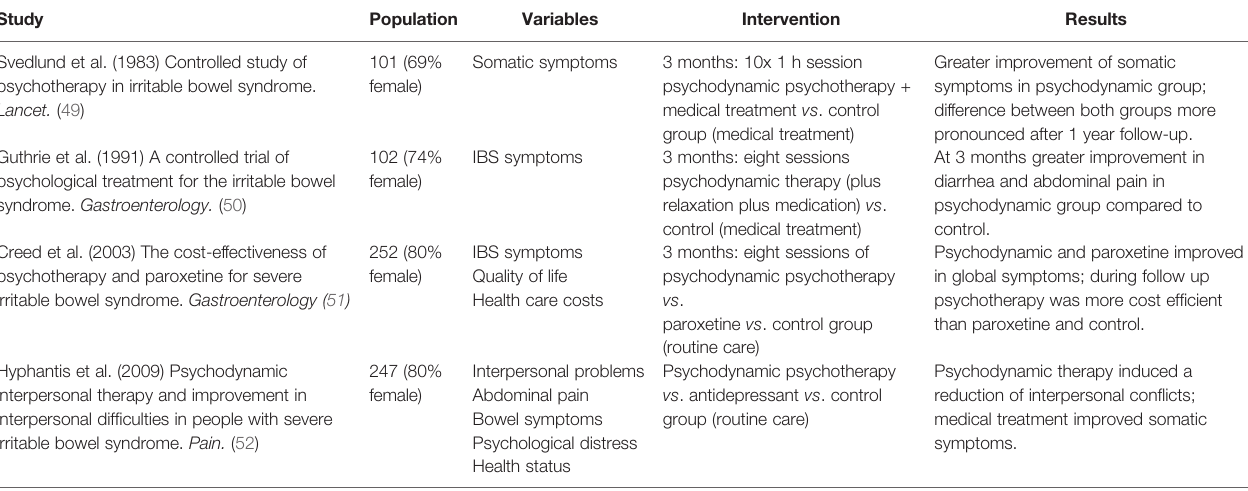
TABLE 4 | Randomized controlled studies investigating the effects of psychodynamic psychotherapy in patients with irritable bowel syndrome. Study Population Variables Intervention Results Svedlund et al. (1983) Controlled study of psychotherapy in irritable bowel syndrome. Lancet.